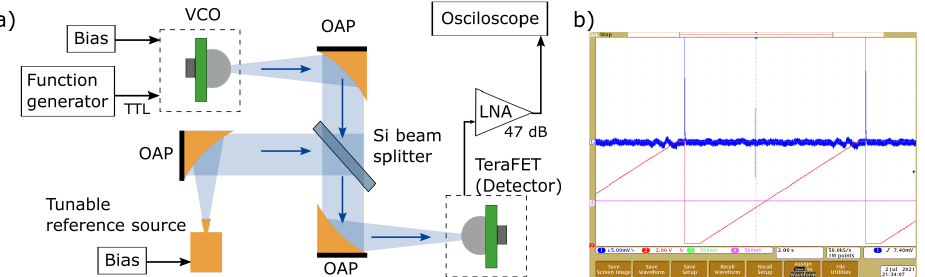
Figure 8. ( a ) Experimental setup for the measurement of the source frequency. ( b ) The photo of the typically recorded oscillogram. The red line - the voltage bias sweep of the reference source, the blue line—the detector’s response. The spike at the center indicates the beat frequency. Two spurious signals appear at the beginning and the end of the sweep. OAP, off-axis parabolic mirror; LNA, low-noise amplifier; VCO, voltage-controlled